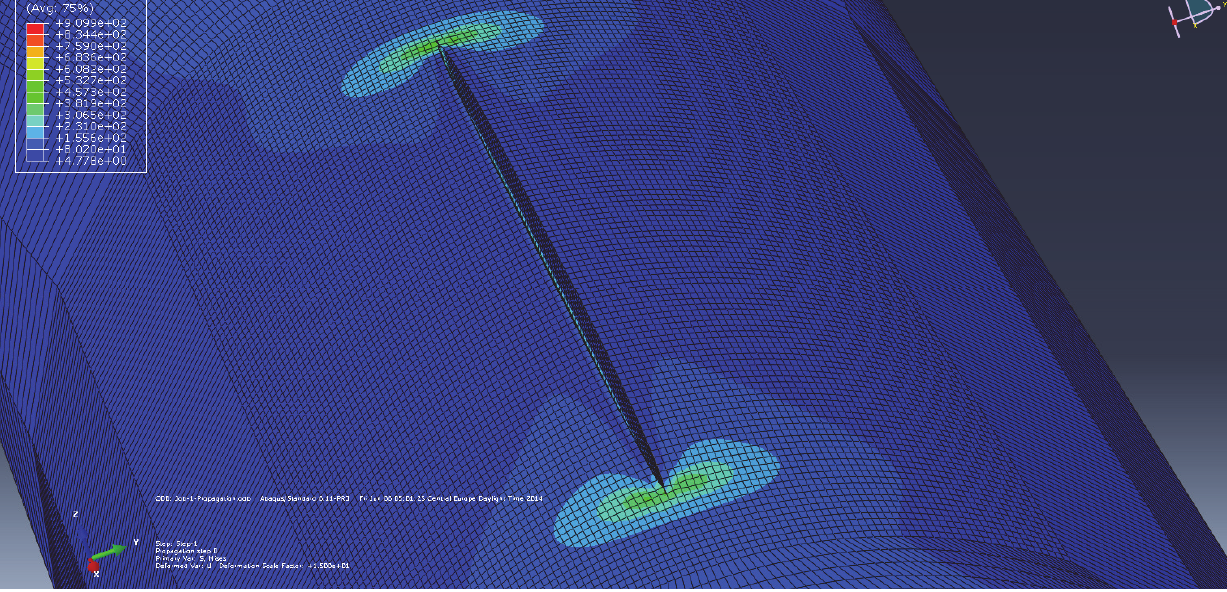
Figure 7: Step 1 - crack opening and Von Mises stresses at crack tips.